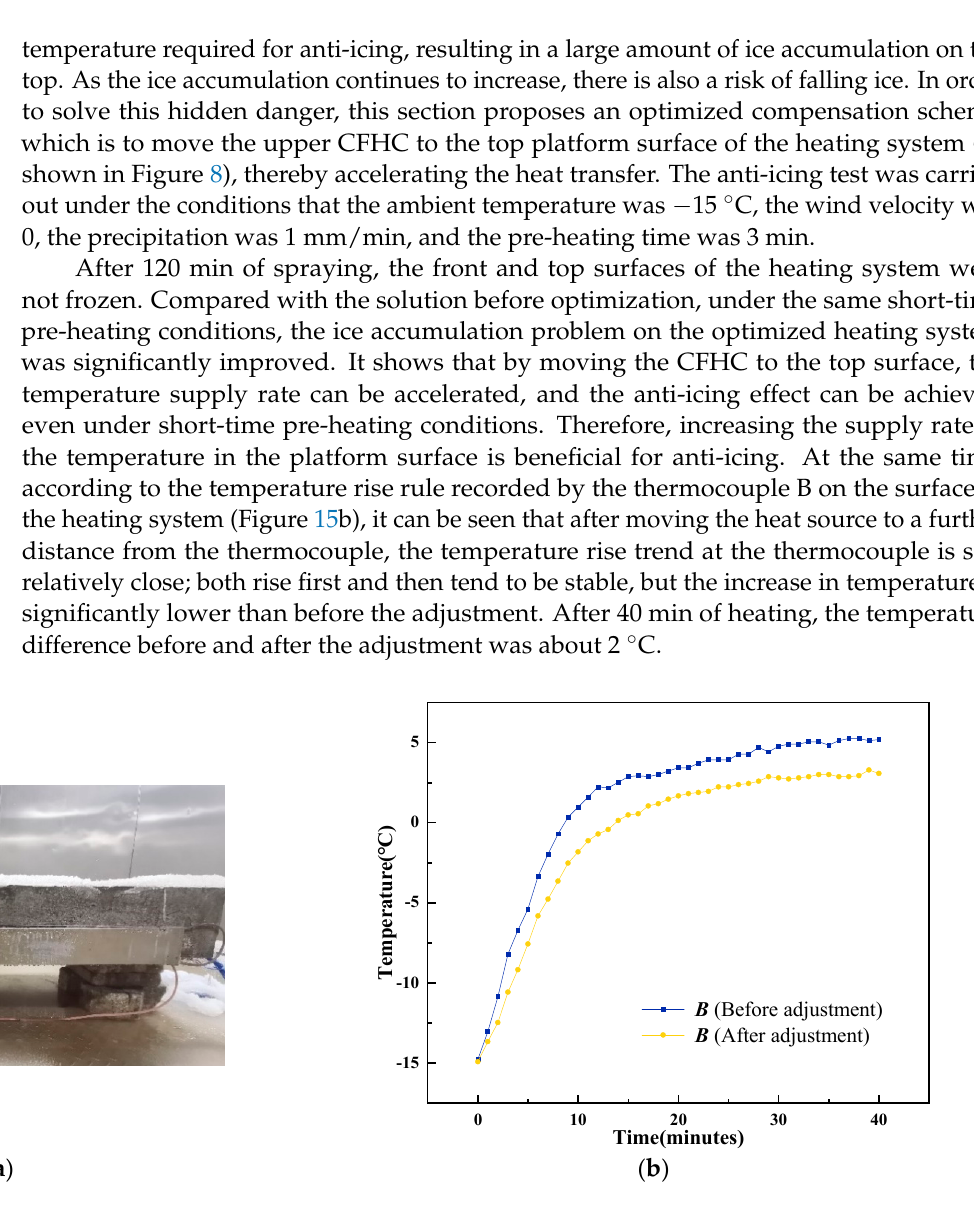
Figure 15. ( a ) Anti-icing effects after rearranging the CFHC; ( b ) temperature rise rule after rearranging the CFHC under the rainfall condition.